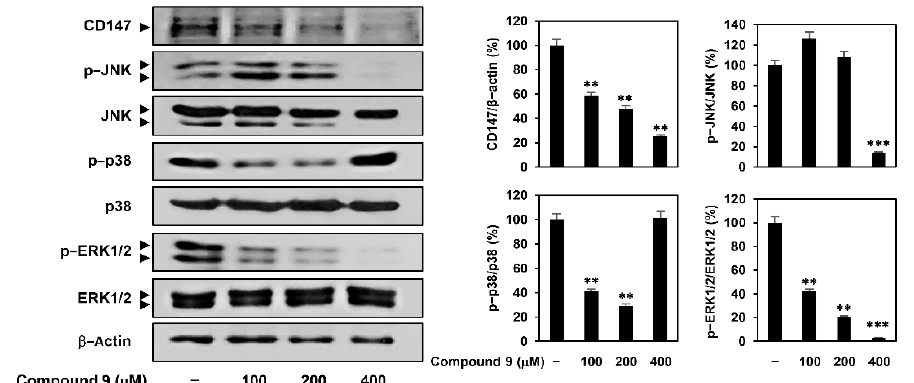
Figure 3. Effect of compound 9 on the CypA/CD147 pathway in AGS cells. AGS cells were treated with compound 9 (100–400 μ M) for 24 h. Protein levels were detected by western blot analysis and further quantified by densitometry. The level of β -actin was used as an internal control. ** p < 0.01, *** p < 0.001 vs. the control.